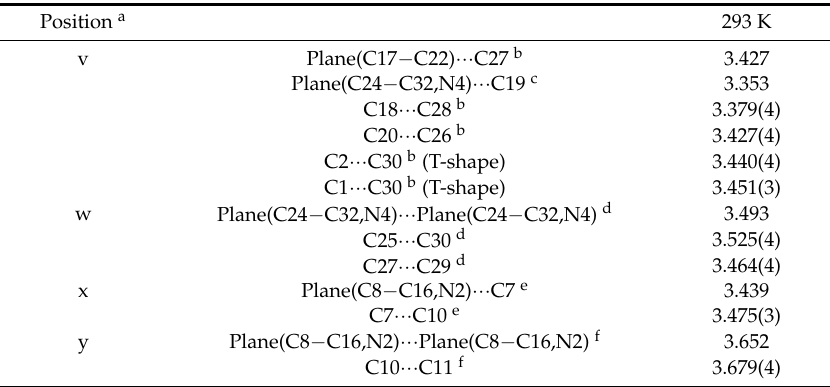
Table 8. Selected intermolecular distances (Å) in 3